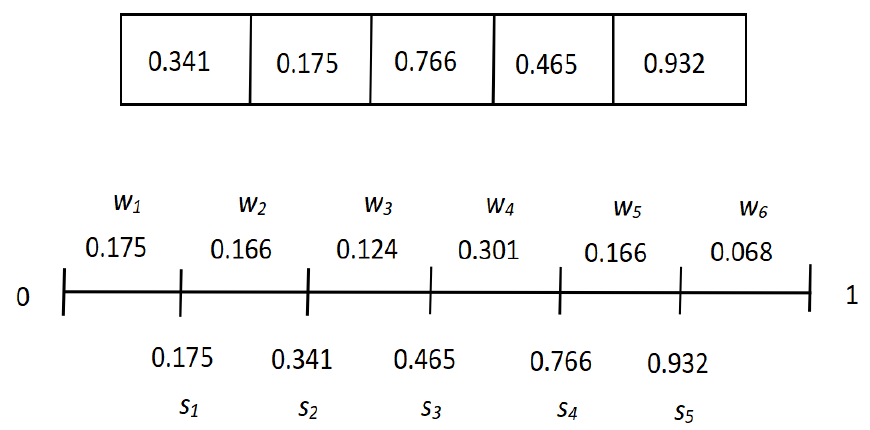
Figure 6. Weight coding and decoding